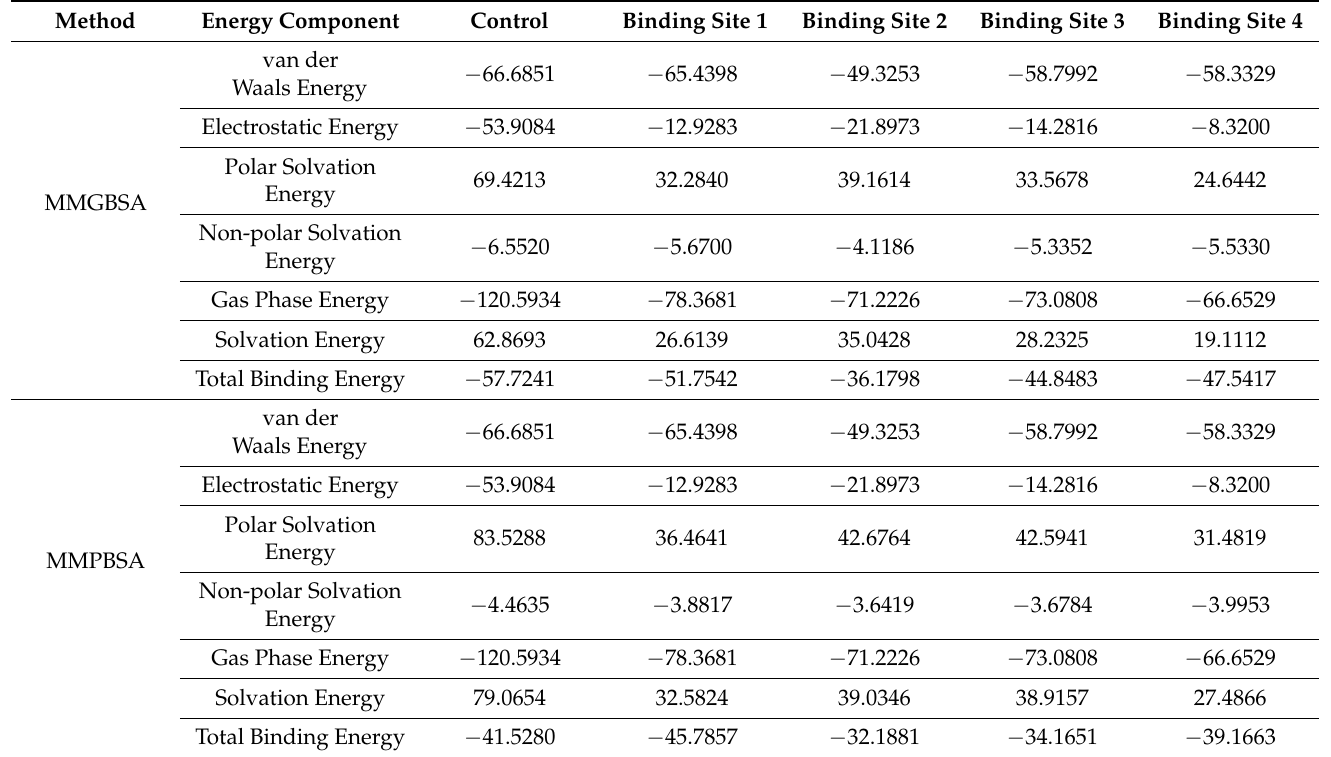
Table 2. Binding free energy results for control and top ranked compounds at different binding sites.